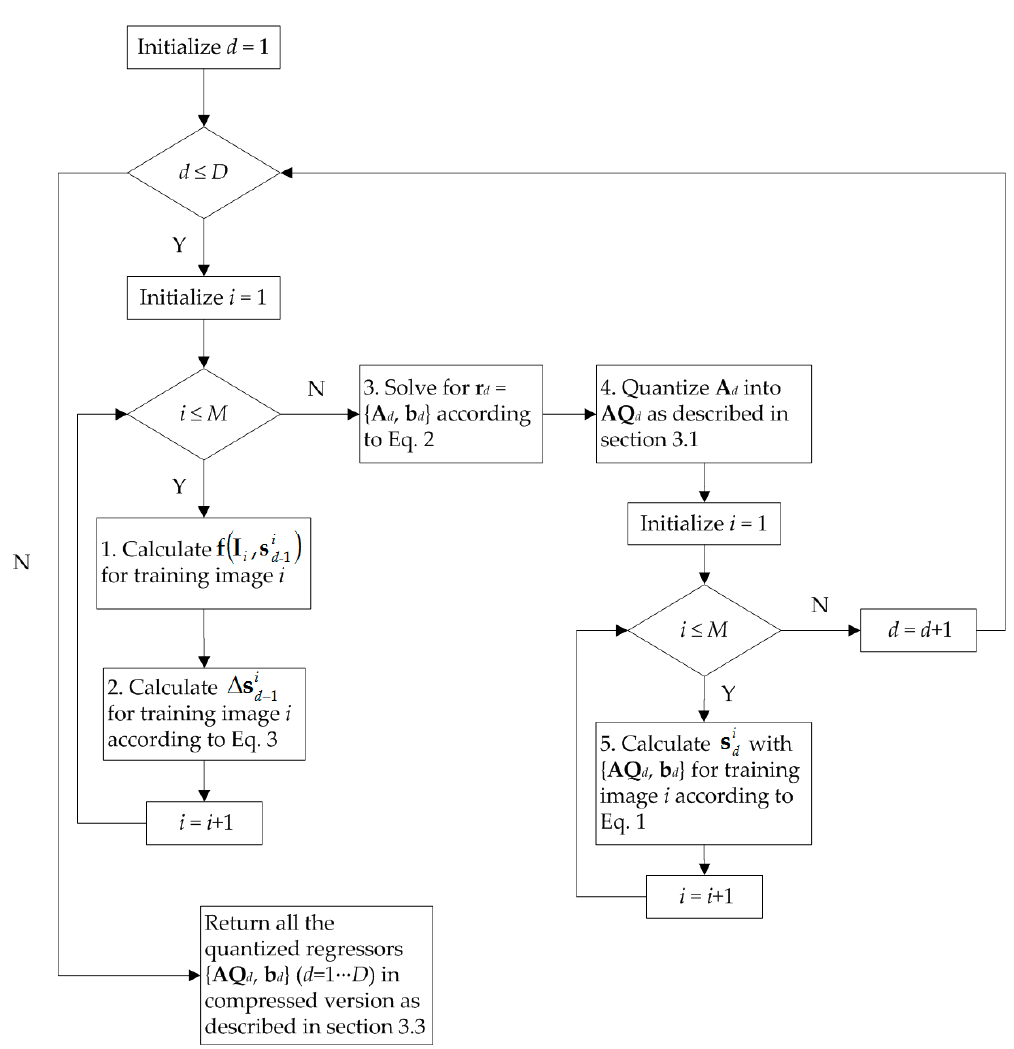
Figure 5. The flow chart of the proposed tightly-coupled training algorithm.